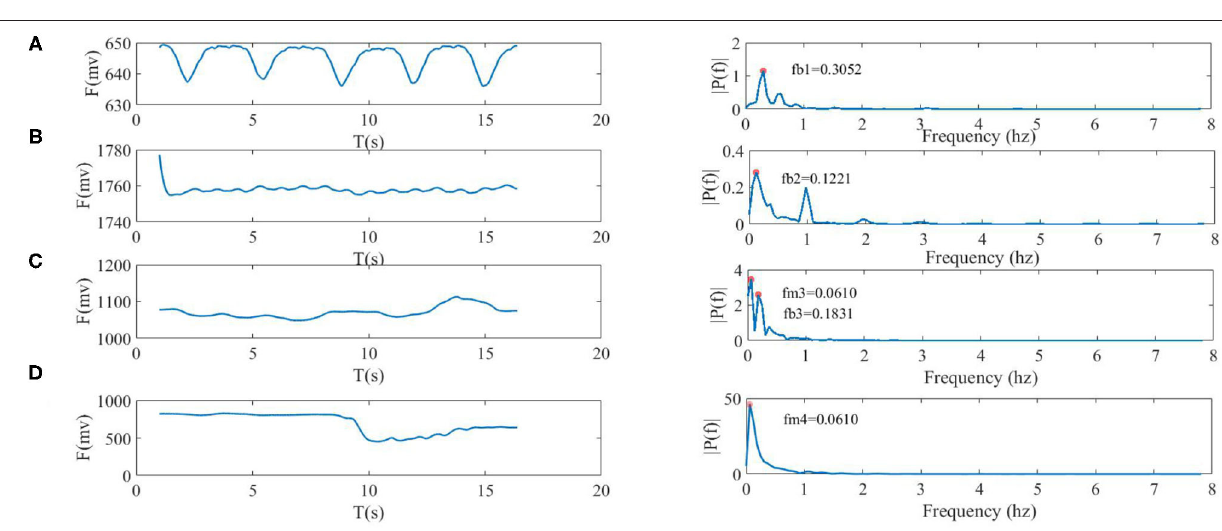
FIGURE 8 | Four types of breath waveforms (the left side) and spectra (right side), where fb1, fb2, and fb3 were frequencies of respiration, and fm3 and fm4 were frequencies of movement. (A) static state, fb10 = 0.3052Hz, (B) the held breath state, fb20 = 0.1221Hz, (C) slow breath was accompanied by body movement which included fb30 = 0.1831Hz and fm3 = 0.0610Hz, and (D) the movement state only included fm40 = 0.0610Hz of moved